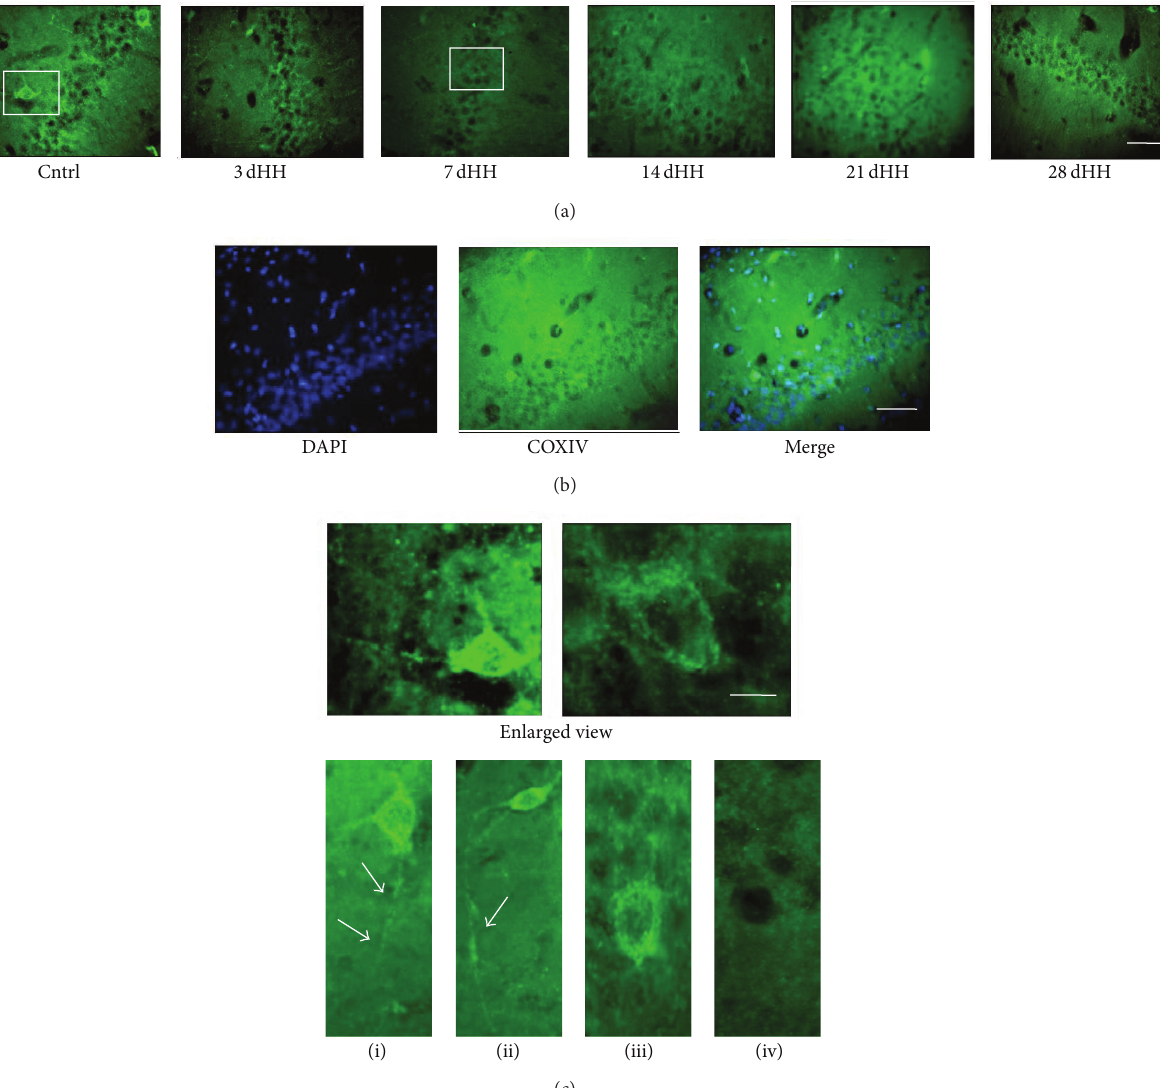
Figure 5: (a) Representative fluorescence micrograph of the temporal alterations of COX IV (mitochondrial respiratory complex IV) distribution and expression in HH exposed CA1 hippocampal region. (b) CA1 region COX IV merged with DAPI. (c) Enlarged view depicts mitochondria in neuron. Figures (i) and (ii) depict that mitochondria are equally distributed in cell soma, axons, and dendrites in Cntrl rat hippocampal tissue and figures (iii) and (iv) depict that reduction in mitochondria and distribution constraints to cell soma only in 7 dHH exposed hippocampal tissue. Yellow colour arrows indicate mitochondria as green dots of high fluorescence intensity. Data are expressed as mean ± SD; 𝑛 = 3 . Scale bar 10 𝜇 m, 20 𝜇